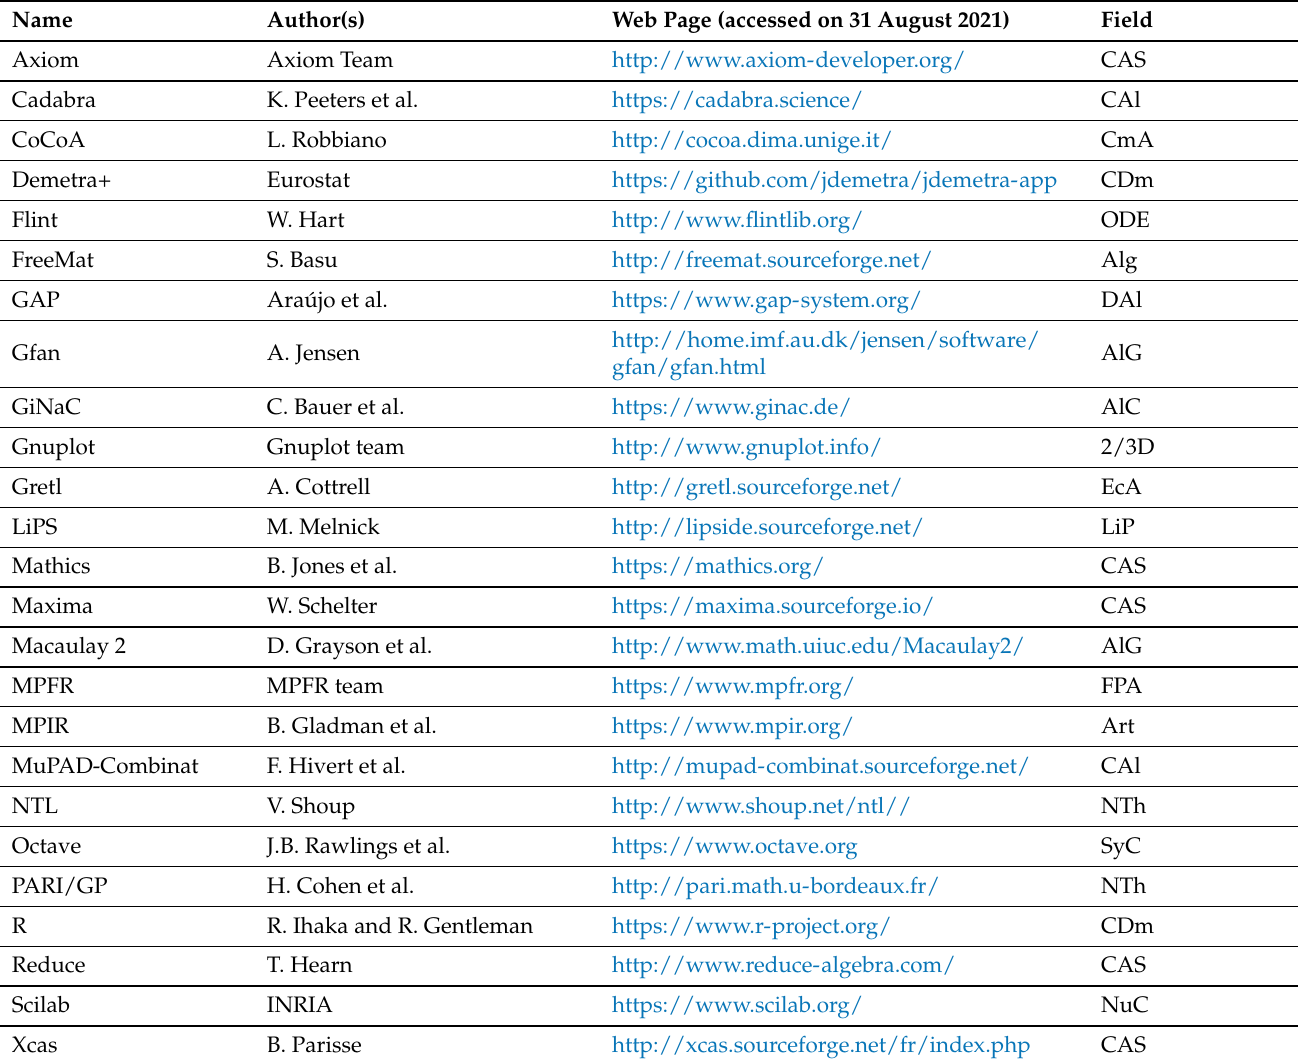
Table 1. Additional open source mathematical software